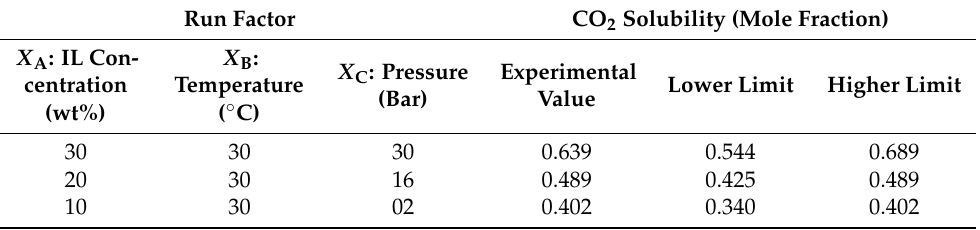
Table 7. Results of operating conditions with experimental design in confirmation